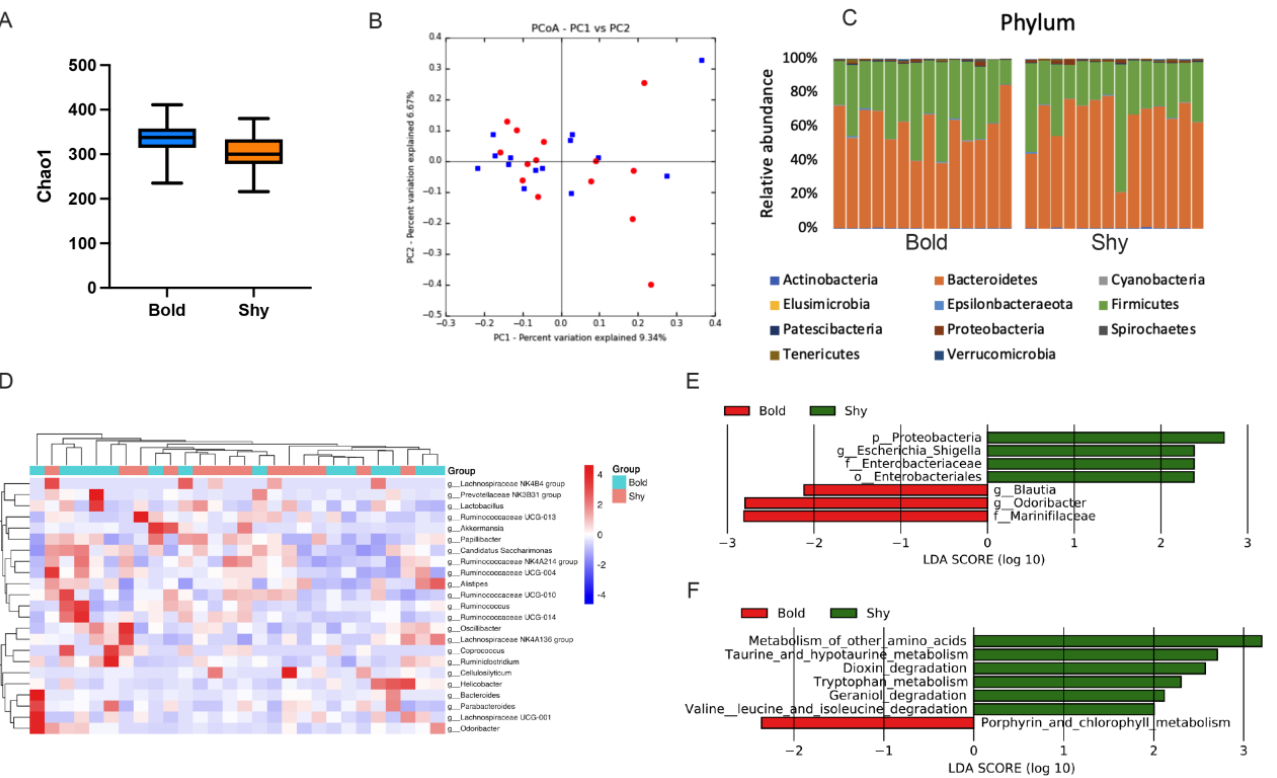
Figure 1. The comparisons of gut microbiota diversity between bold and shy personalities in Mon- golian gerbils. ( A ) Alpha diversity (Faith’s phylogenetic diversity) of bacterial communities across groups. ( B ) PCoA plot based on Bray–Curtis distance metrics representing the differences in fecal microbial community structure in different groups (PERMANOVA). ( C ) Abundance represented as the proportions of ASVs classified at the phylum rank. ( D ) Cluster heatmap showing the proportions of ASVs classified at the genus rank. ( E ) Differential bacterial taxonomy selected by LEfSe analysis with LDA score > 2 in microbiota. ( F ) Predicted microbial functions using PICRUSt. Relative abundances of KEGG pathways by LEfSe analysis with LDA score > 2. Data are means ± SEM.